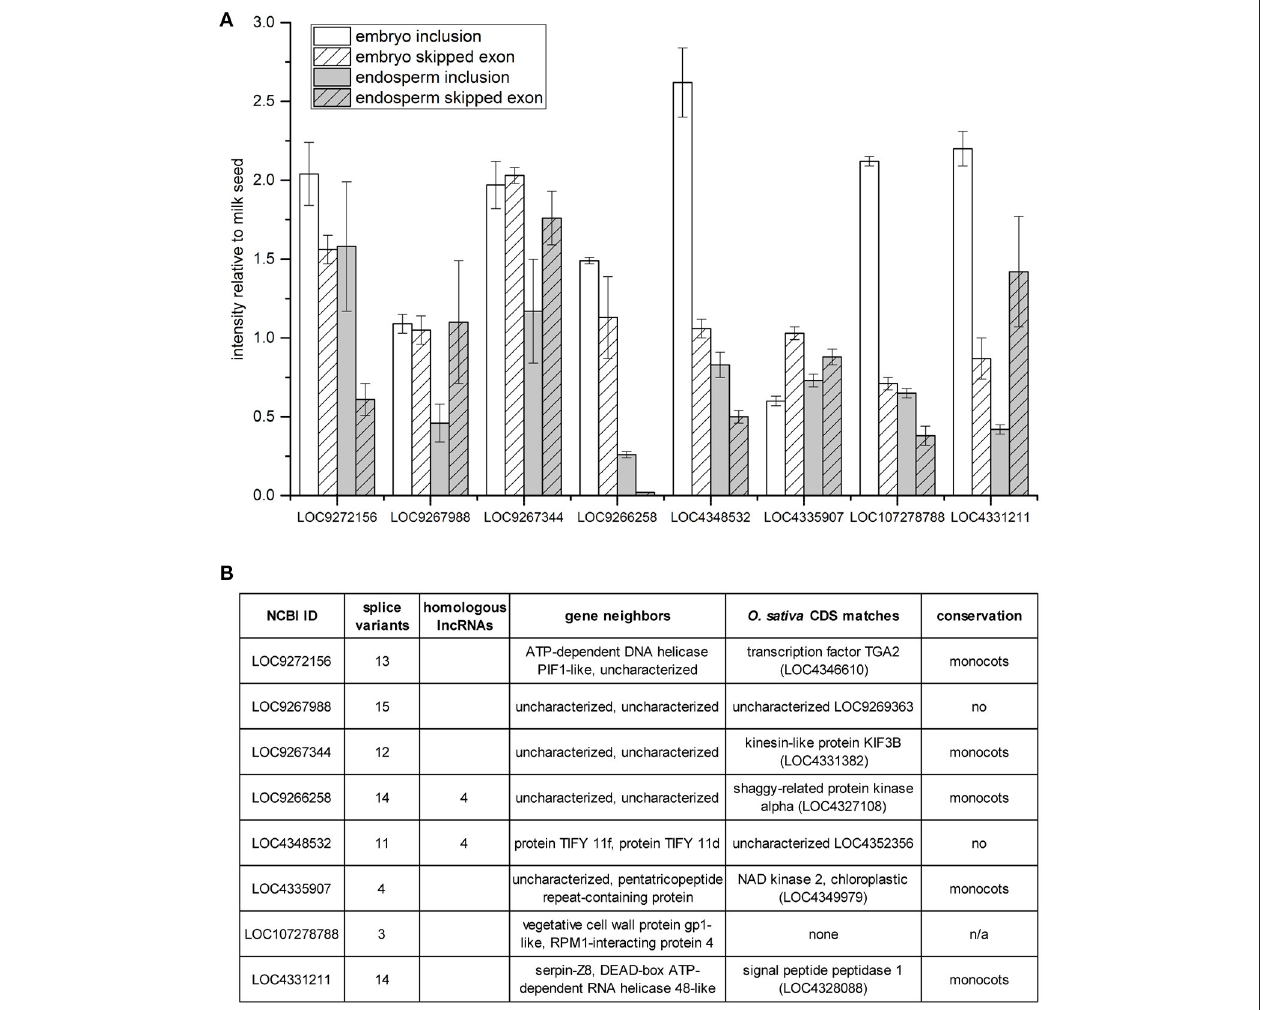
FIGURE 5 | Exon skipping/inclusion of 8 lncRNAs in embryo and endosperm. (A) Band intensities relative to milk seed ± standard deviation ( n = 3). (B) Homologs, genomic context, sequence matches, and evolutionary conservation of lncRNAs in (A) .